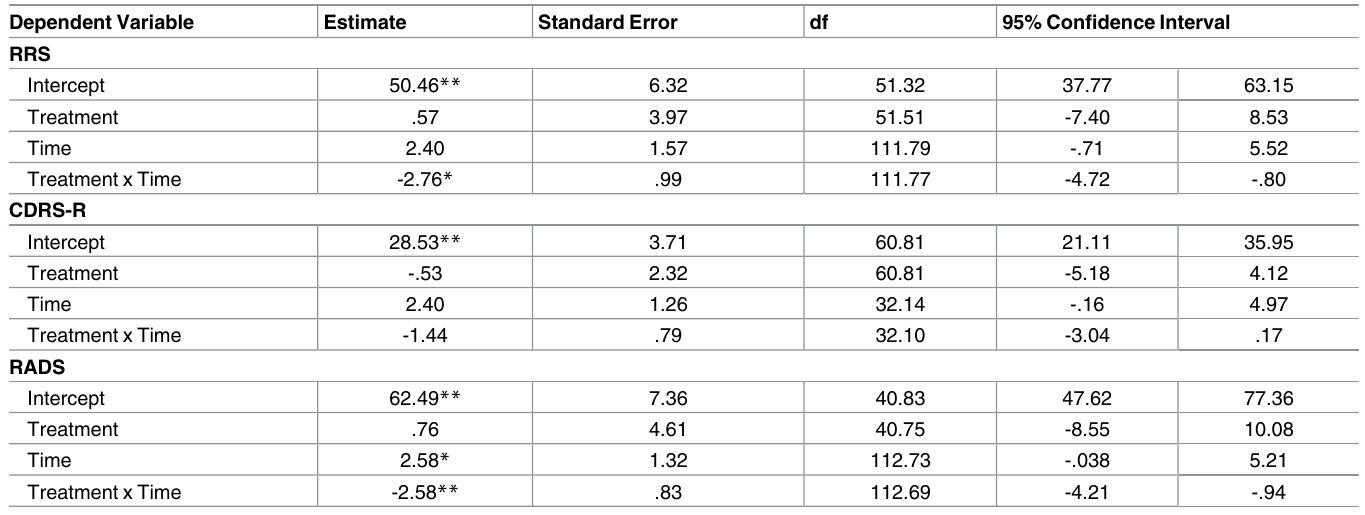
Table 2. Estimatesof Fixed Effects of Group, Time, and Their Interaction on Rumination and